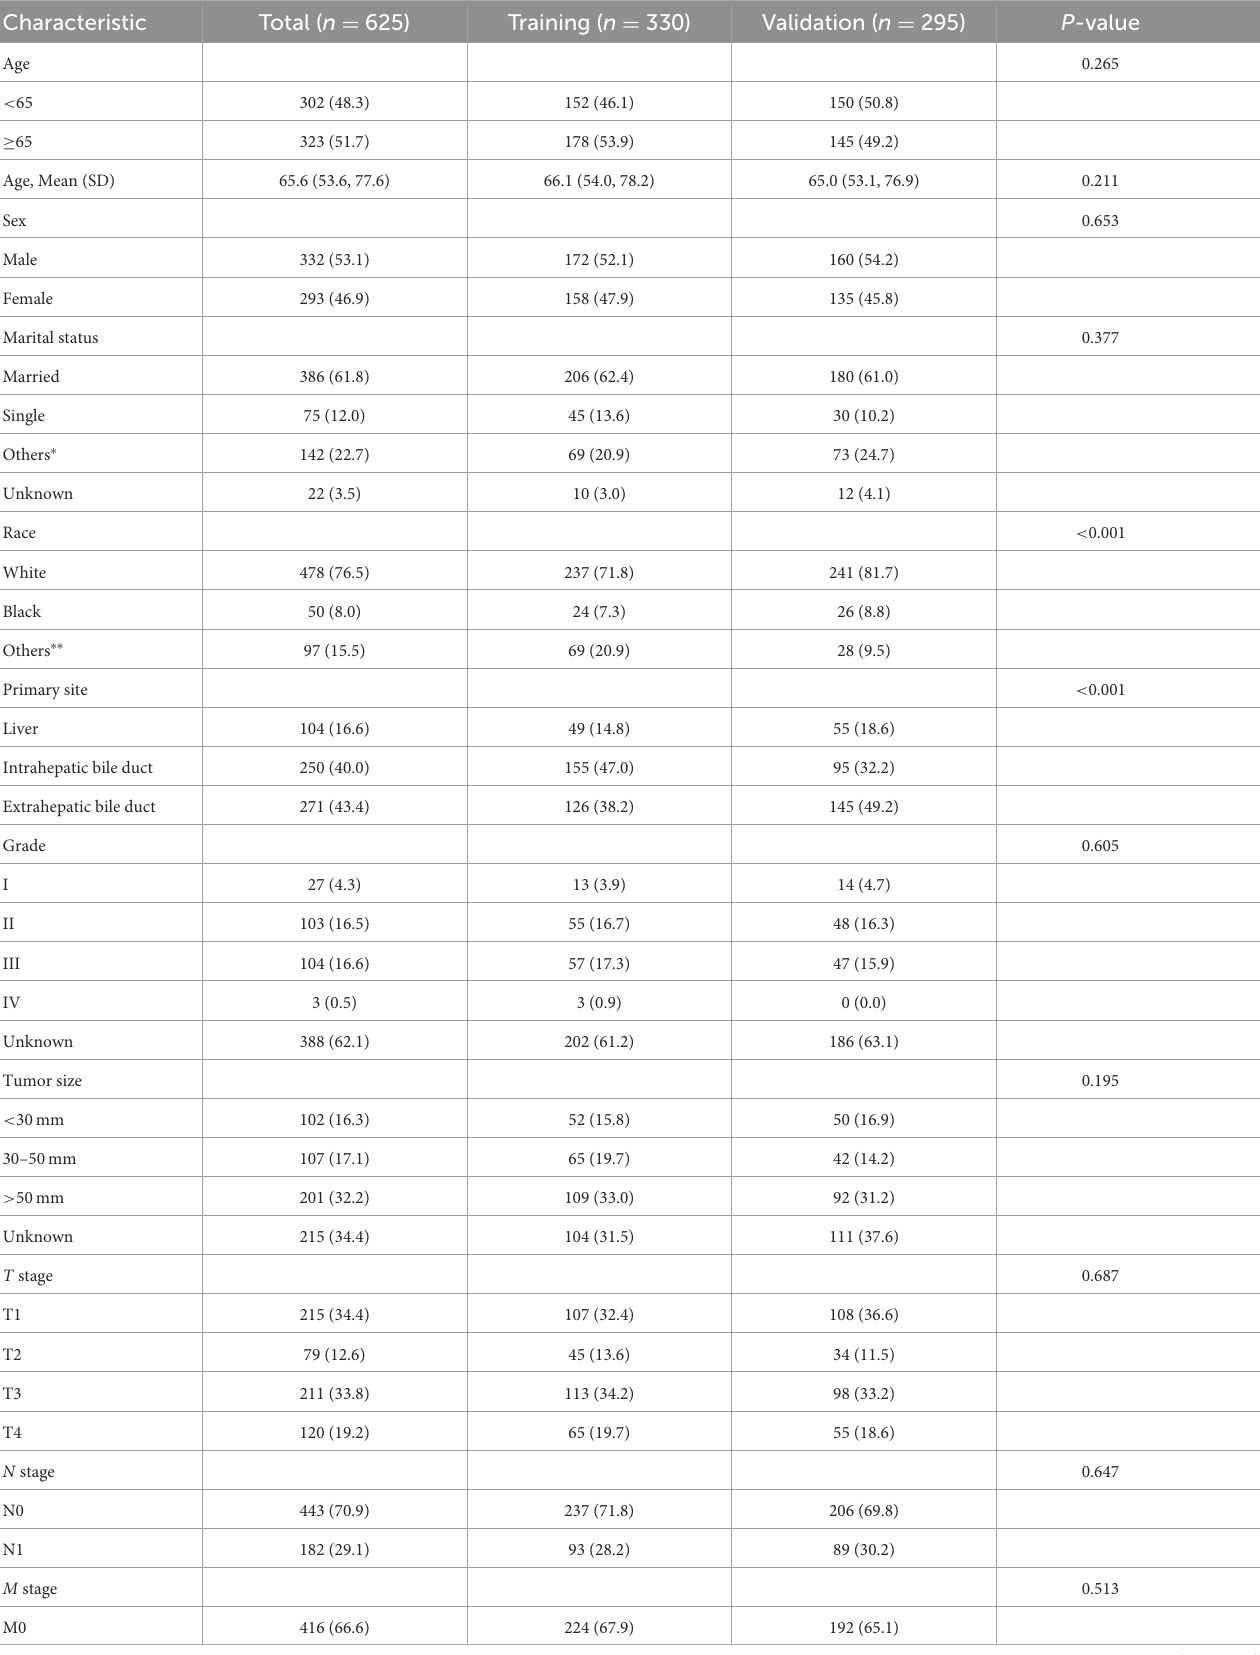
TABLE 1 Baseline characteristics of patients in the training cohort and validation cohort from SEER database.